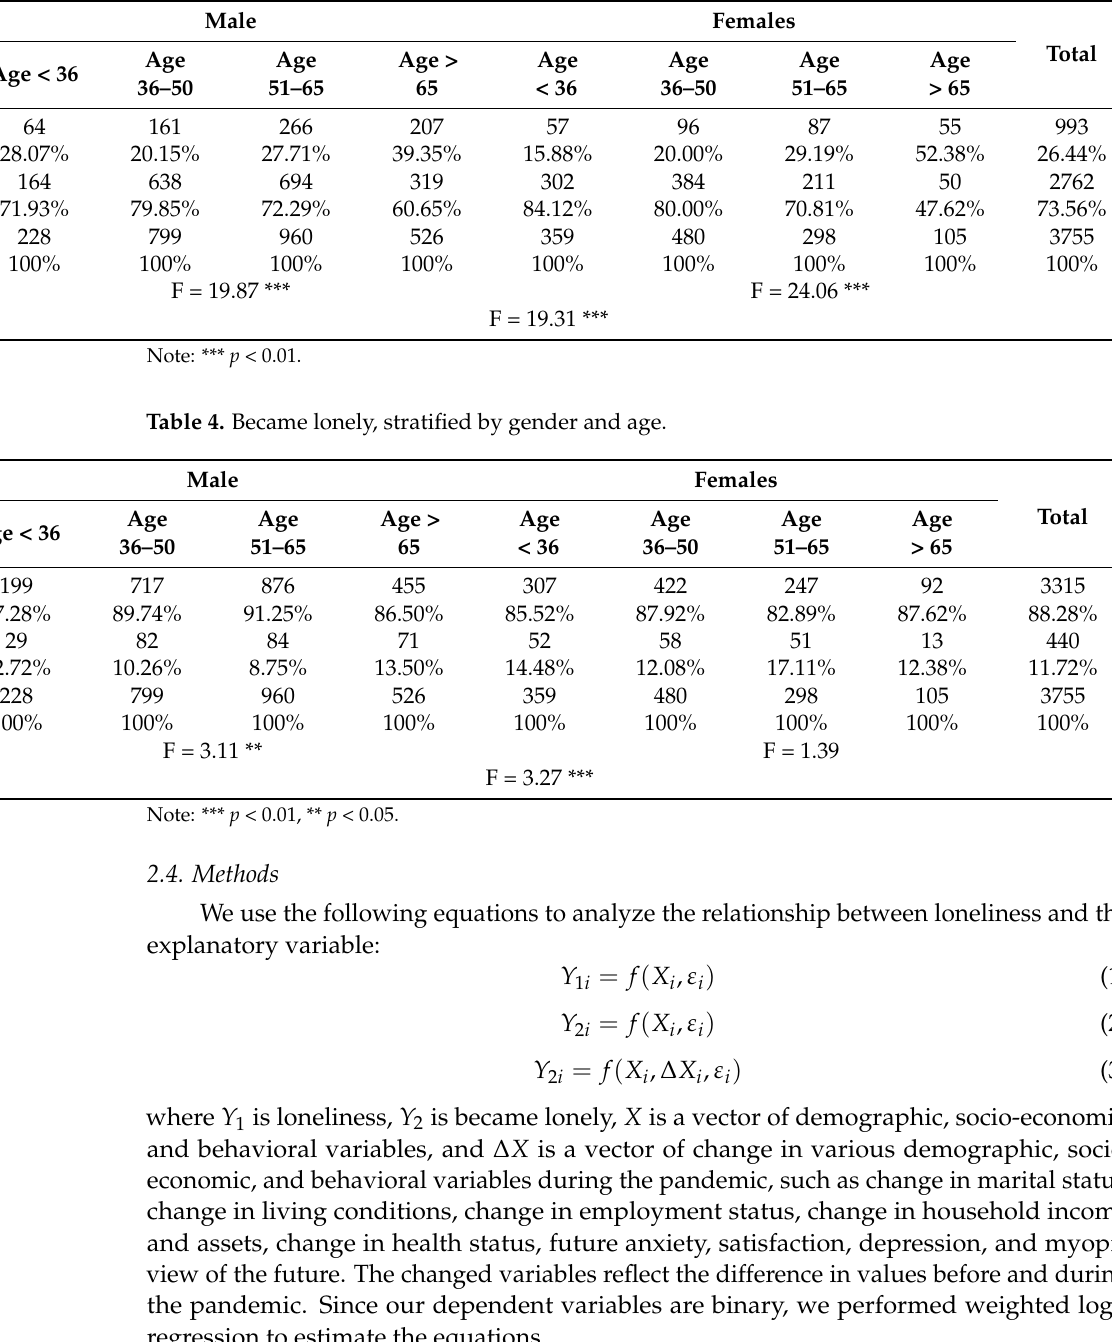
Table 3. Loneliness, stratified by gender and age.